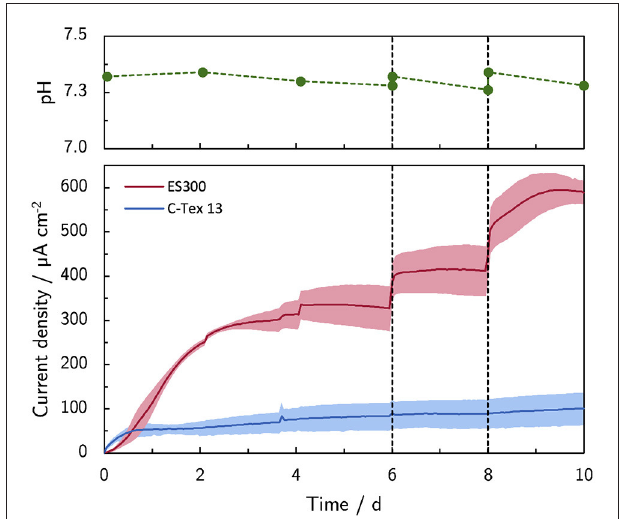
FIGURE 1 | Effect of the buffer capacity on the current production. The initial buffer concentration of 10m M was increased on day 6 to 20m M (+10m M ) and on day 8 to 40m M (+20m M ). Note the stable pH during the experiment. The shaded area corresponds to the sample standard deviation of three anodes. The numerical values of the current densities on day 6, 8, and 10 can be found in Supplementary Table 4 .